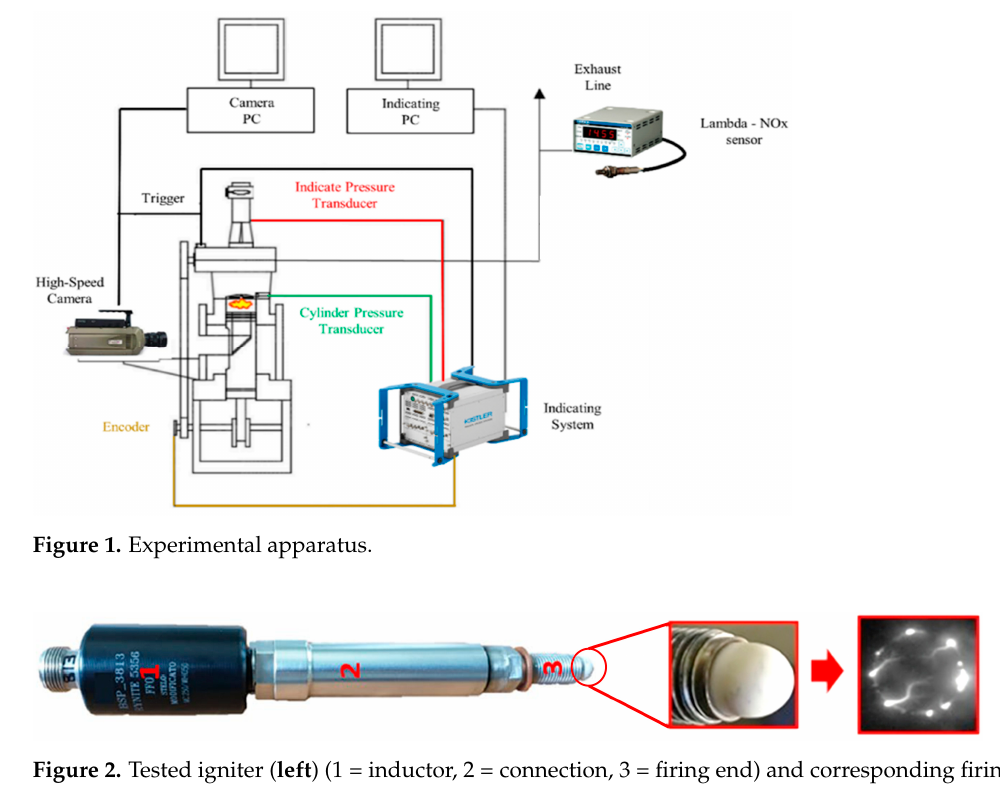
Figure 2. Tested igniter ( left ) (1 = inductor, 2 = connection, 3 = fi ring end) and corresponding fi ring end detail ( middle ). Discharge event ( right ): ionization waves (i.e., streamers) propagated above the igniter cupola.